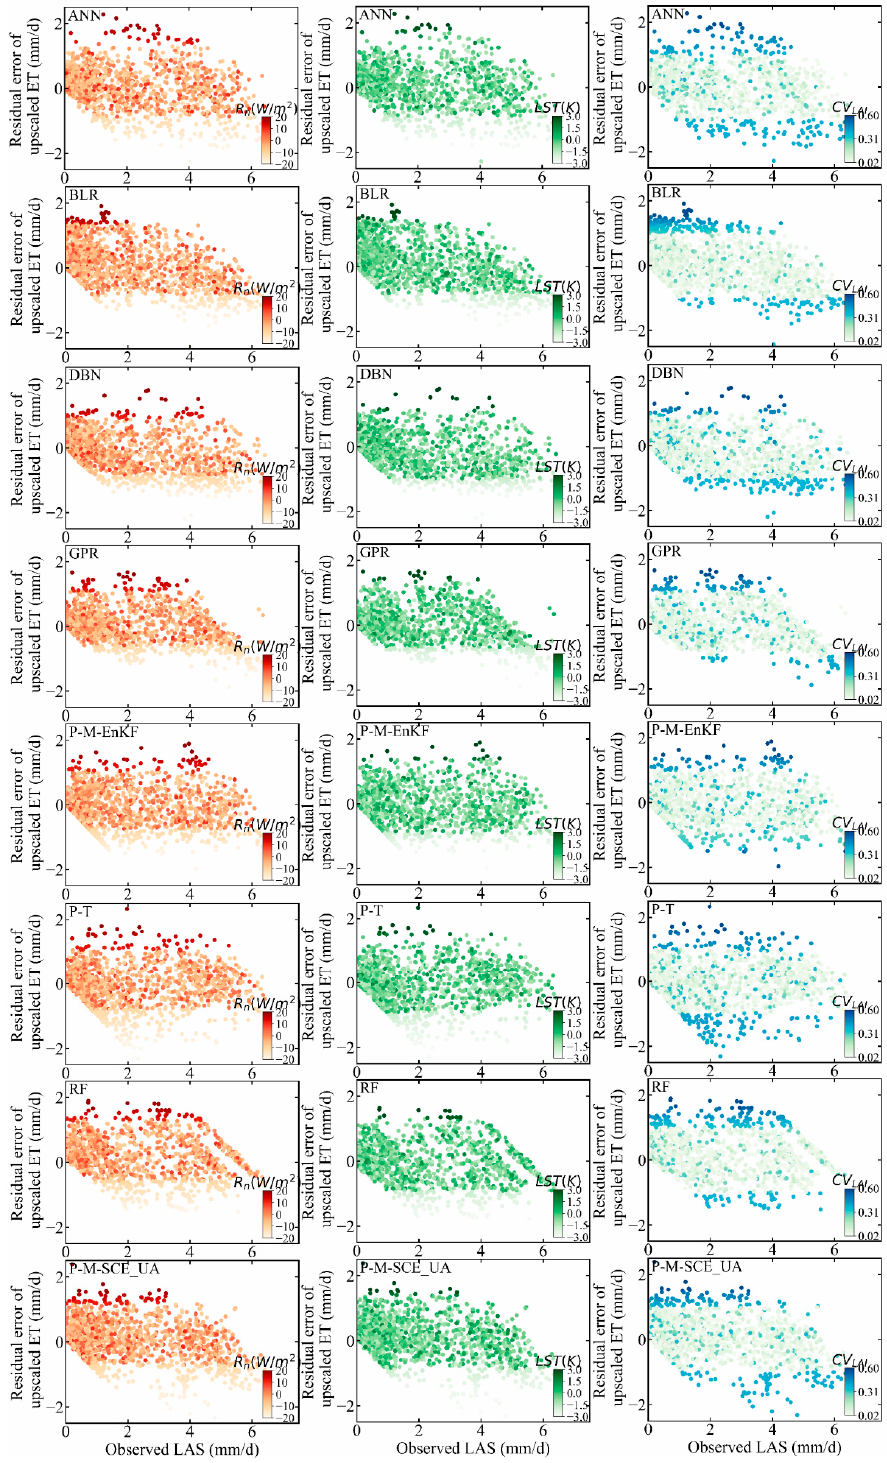
Figure 7. Relationships of the residual error in the upscaled ET derived from the eight upscaling methods with the observed LAS, and the retrieval accuracy of 𝑅 (cid:3041) , LST, and CV (cid:3013)(cid:3002)(cid:3010) at three superstations (the color ramp represents the retrieval error and heterogeneity).